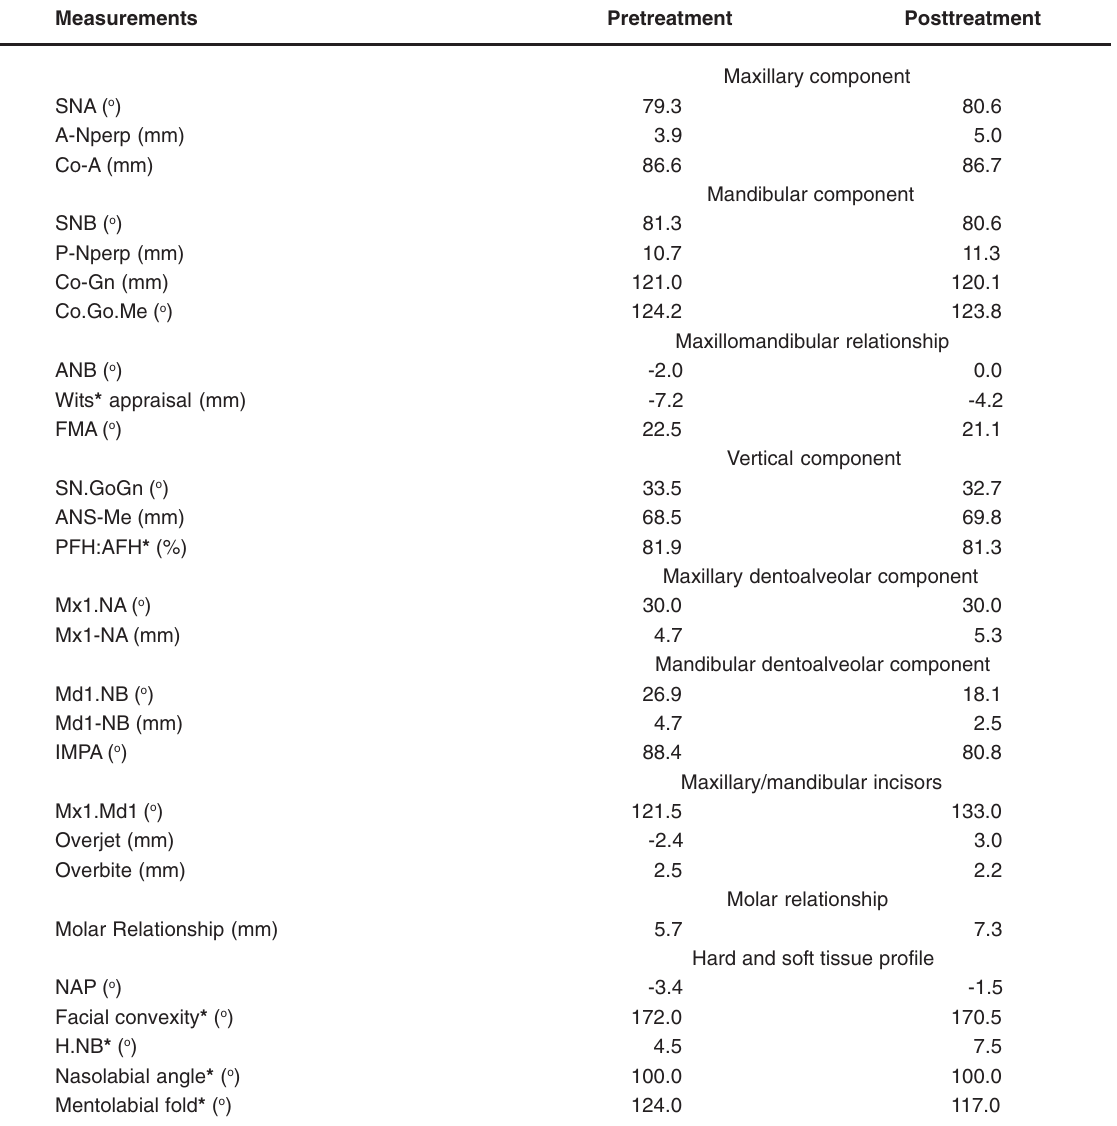
TABLE 1- Cephalometrics